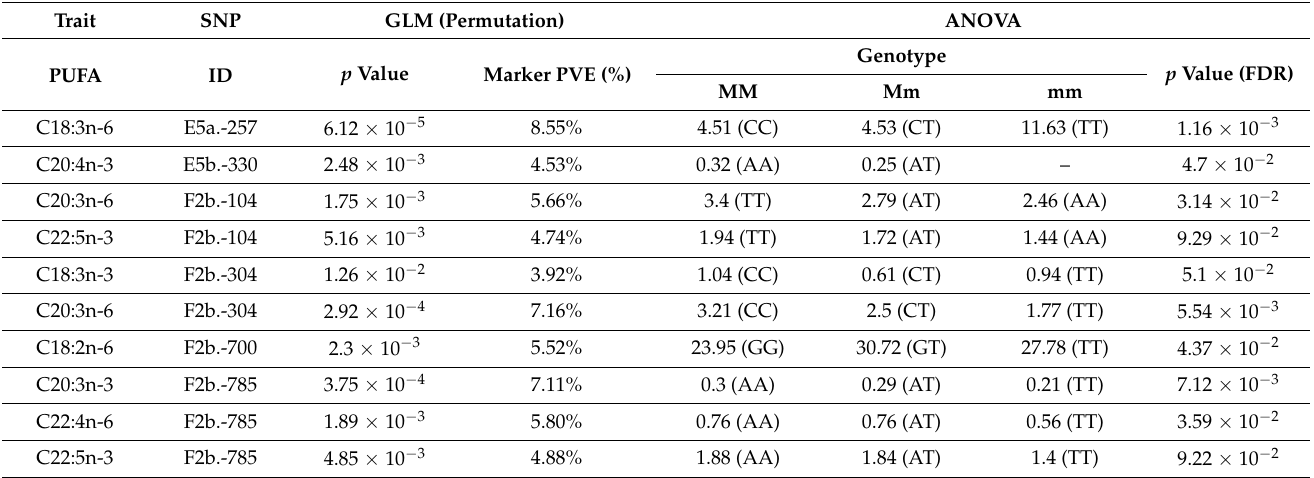
Table 2. Association analysis of PUFAs contents using combining analysis of GLM and ANOVA in common